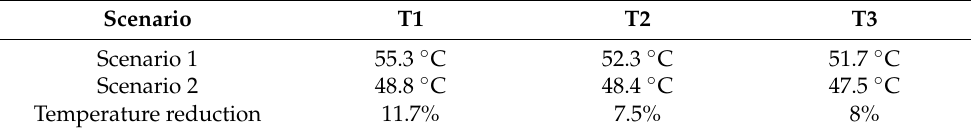
Table 3. Temperature comparison of the LiC for two scenarios: without TMS and with